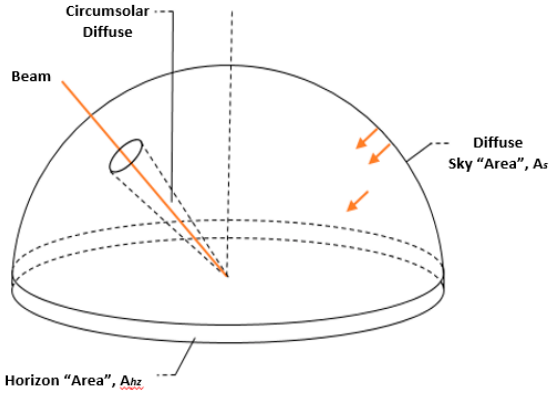
Figure 9. Distribution of solar radiation.